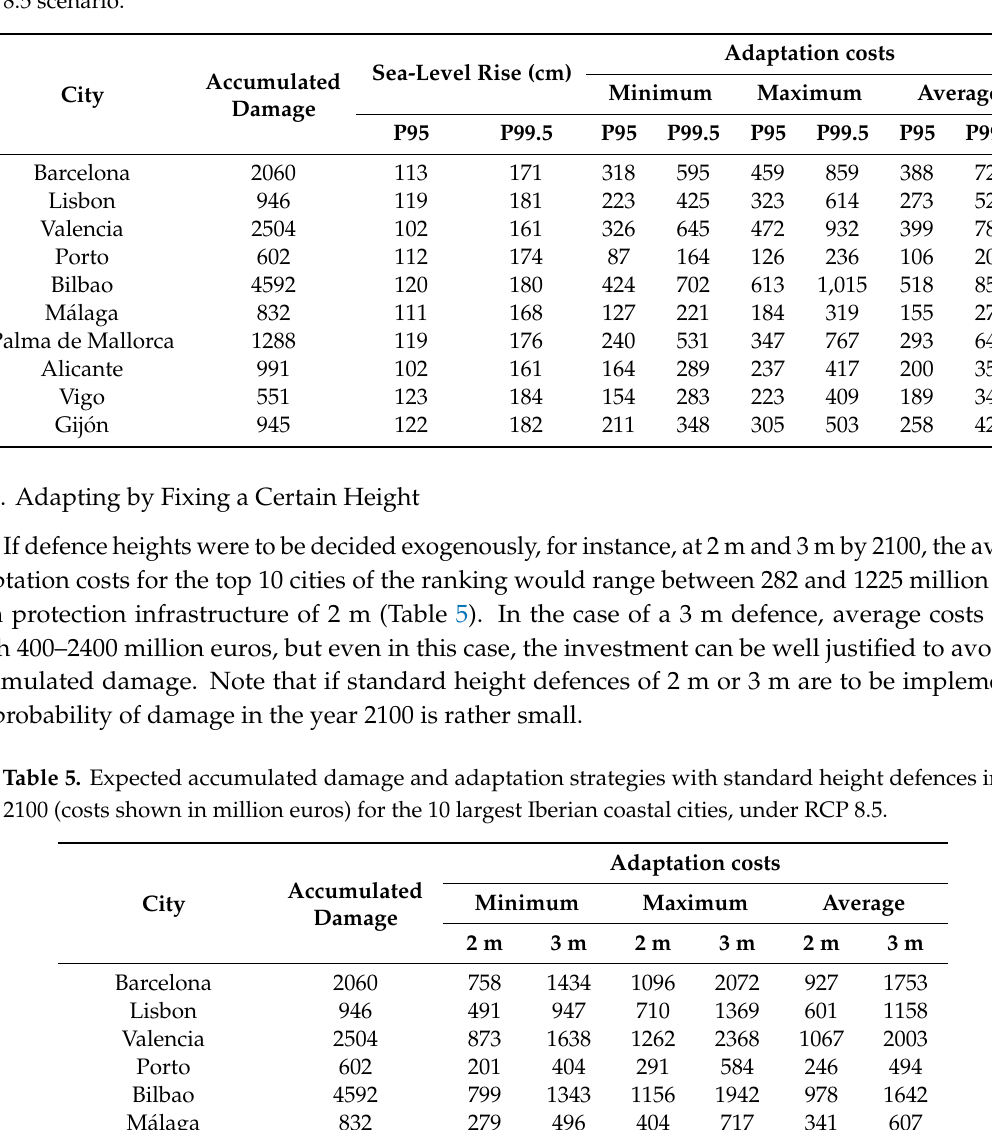
Table 4. Expected accumulated damage and adaptation strategies linked to sea-level rise percentiles (in million EUR) in 2100 for the 10 Iberian coastal cities with the largest populations under the RCP 8.5 scenario.